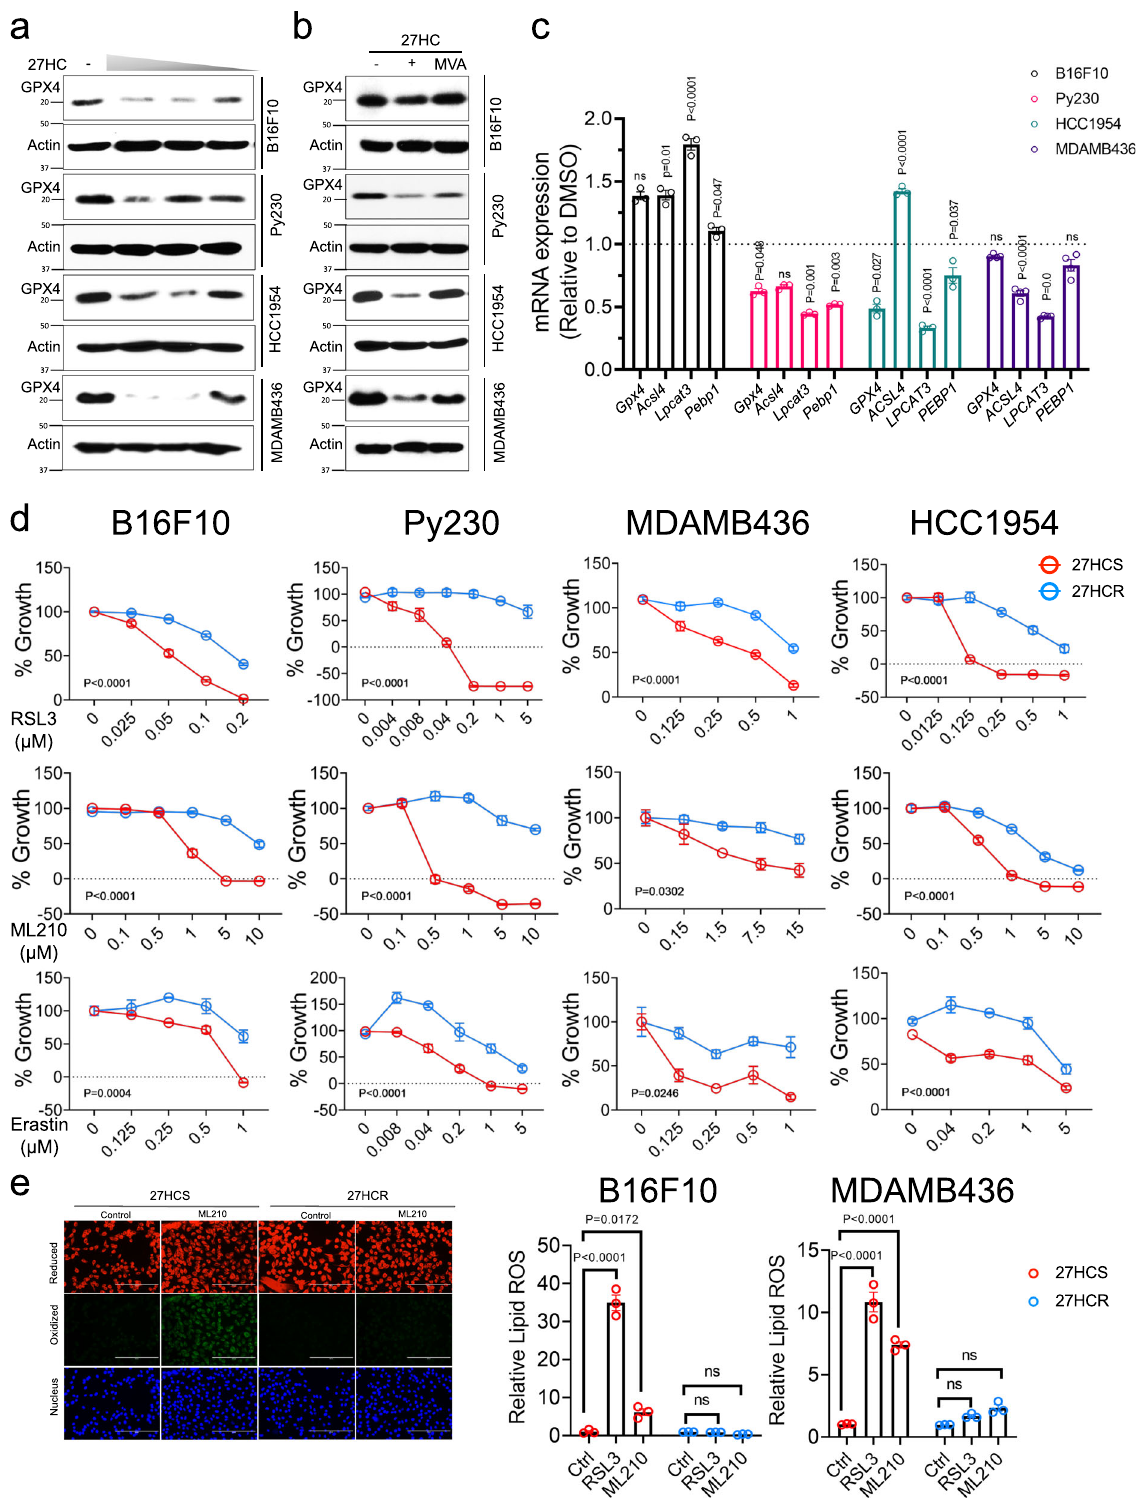
expression 55 . This drug inhibits the Xc-transporter (xCT) and decreases the ability of cells to import cystine an amino acid, which is required for GPX4 activity. It was observed that both 27HC and erastin inhibited the expression of GPX4 in 27HCS cells, albeit to different degrees (Supplementary Fig. 6a). In some 27HCR derivatives (B16F10 and 4T1) a modest increase in GPX4 expression was observed. Likely more important, however, was